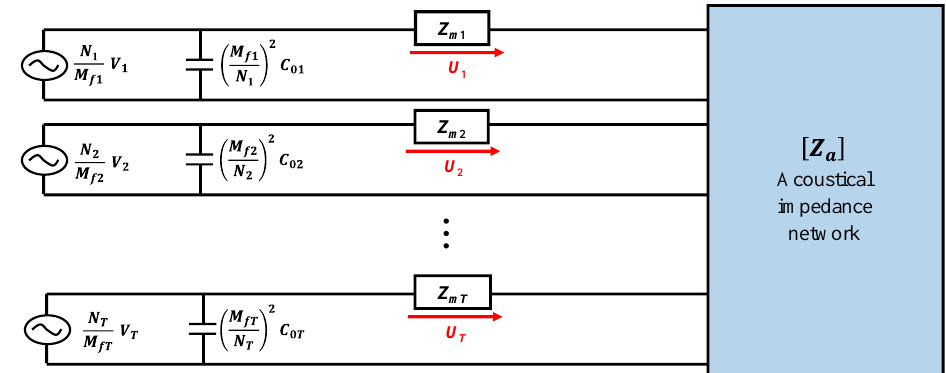
Figure 3. The cymbal array.